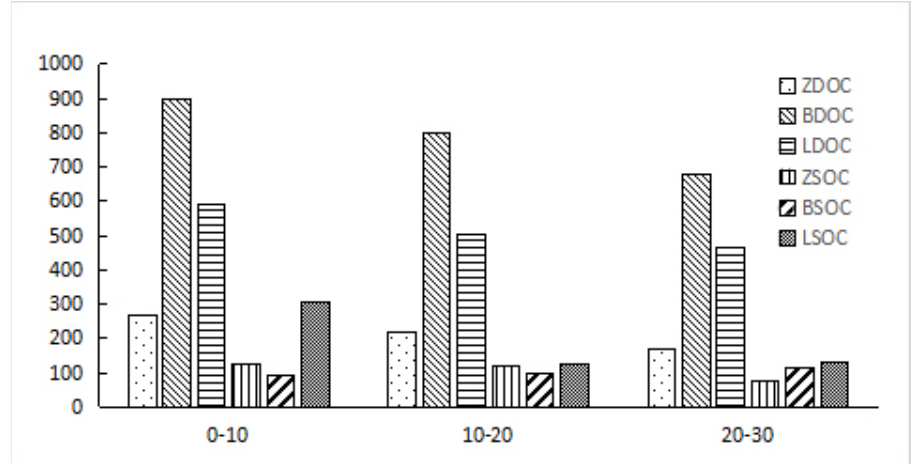
Figure 3. Distribution of the content of SOC and DOC in the soil layers of vertical profiles. (ZDOC—the content of DOC in pinus sylvestris var mongolica forest, BDOC—the content of DOC in birch forest, LDOC—the content of DOC in larch forest. ZSOC—the content of SOC in pinus sylvestris var mongolica forest, BSOC—the content of DOC in birch forest, LSOC—the content of DOC in larch forest).